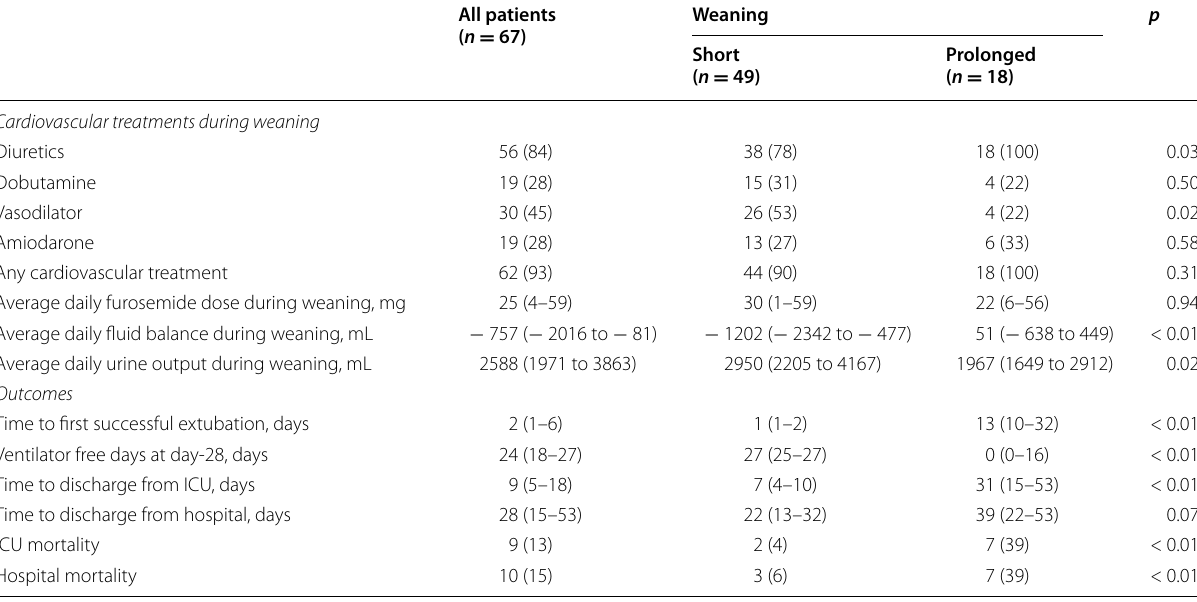
Data are presented as n (%) or median (1st quartile–3rd quartile). Patient who died before day‑28 had 0 ventilator free